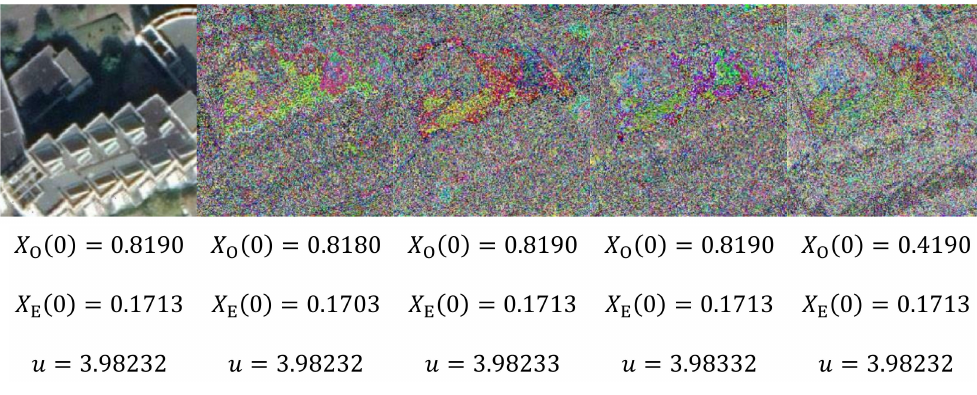
Figure 17. Decryption results with different key.